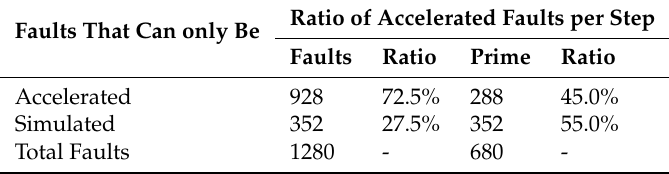
Table 2. Carry adder (CA) fault candidates that are suitable for acceleration.